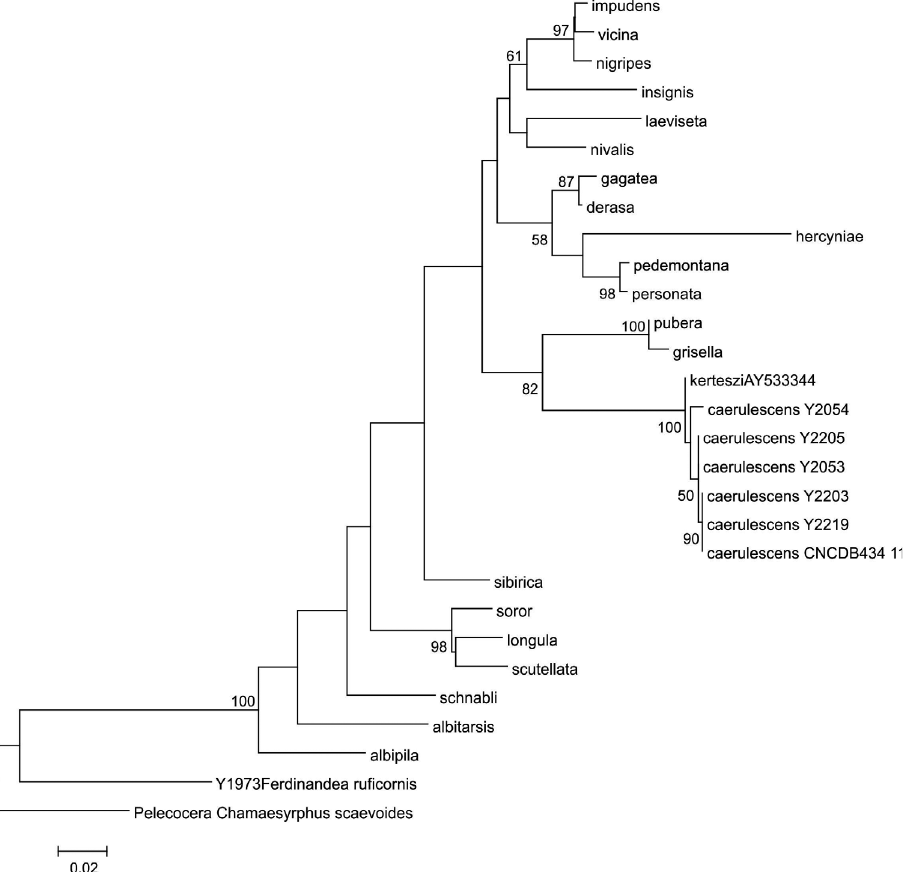
Figure 14. Maximum Likelihood tree with bootstrap support values >50% indicated above